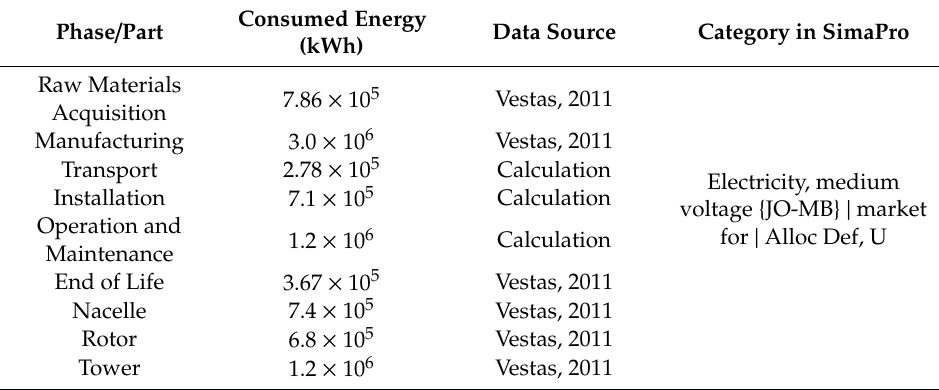
Table 7. Amount of energy consumed for all